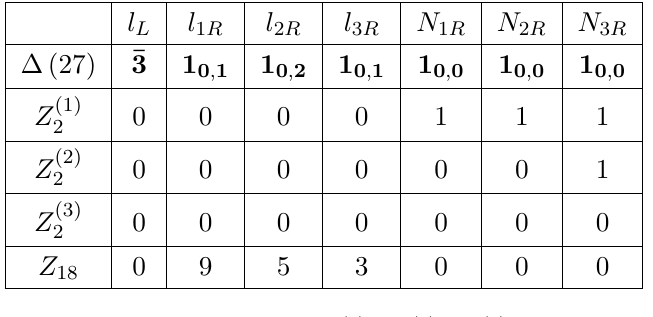
Table 3 . Lepton assignments under the ∆ (27) × Z (1) between the multiple Z 2